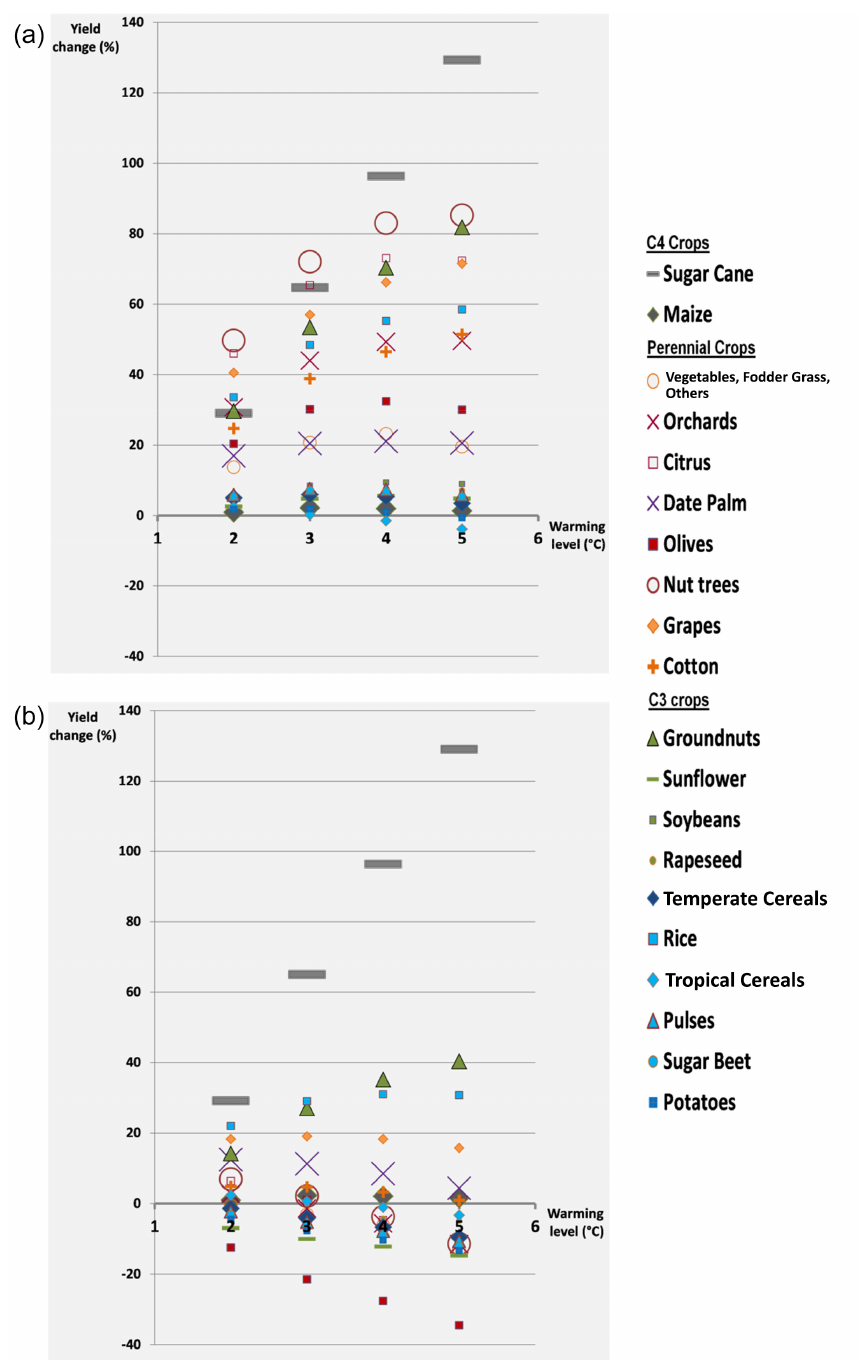
Figure 7. Change in yields from 2000–2009 to 2080–2090 for different crop classes and the DYN (a) and CONST (b) CO 2 -fertilization scenario. Negative (positive) values indicate a decrease (increase) in yields (see Fig. S8 for the RED